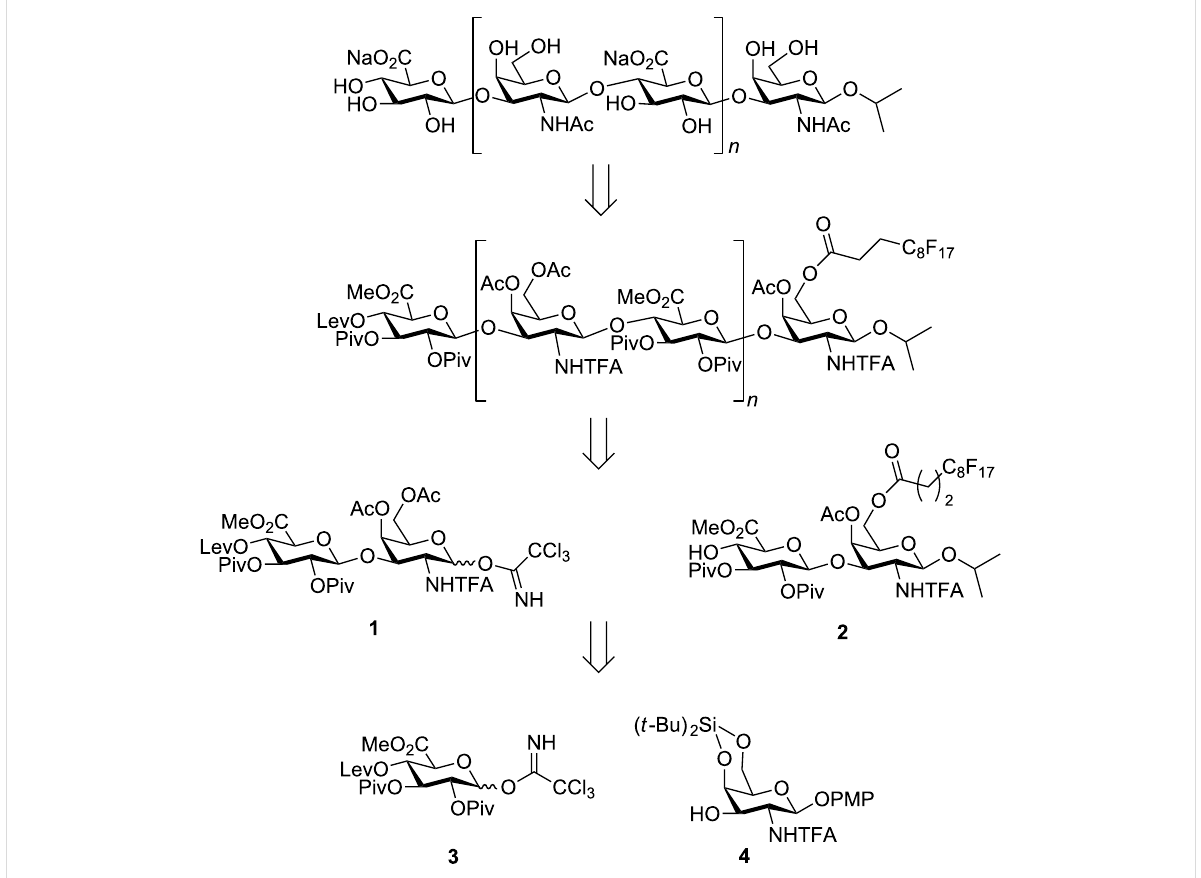
Scheme 1: Retrosynthetic analysis for the preparation of CS oligosaccharides. Lev = levulinyl; Piv = pivaloyl; PMP =